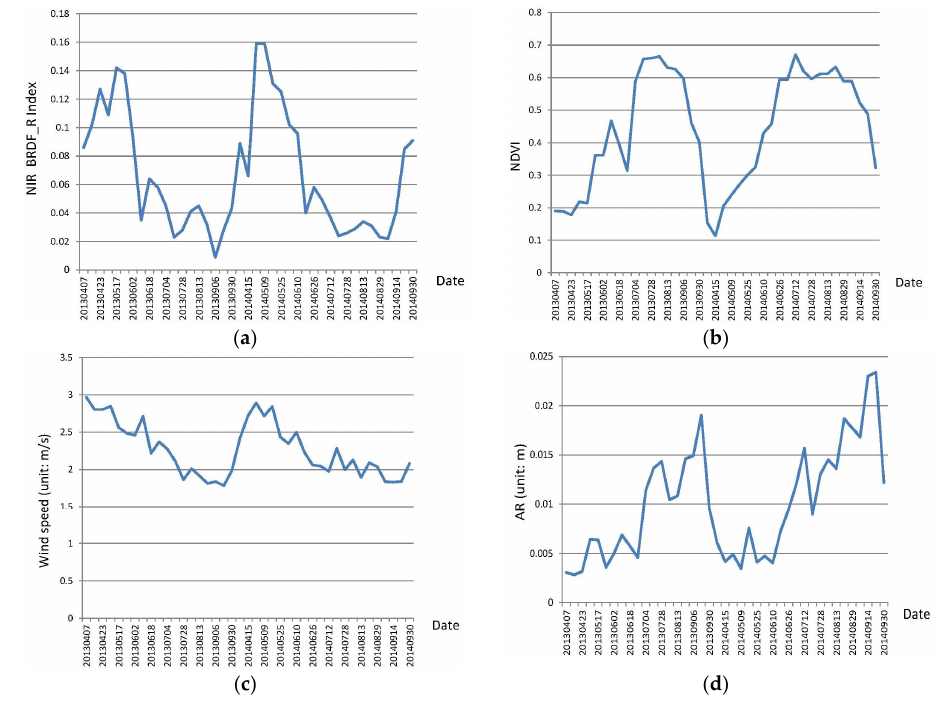
Figure 3. ( a – d ) Change profiles of the Moderate-resolution Imaging Spectroradiometer (MODIS) near-infrared (NIR) bi-directional reflectance distribution function (BRDF)_R index, MODIS normalized difference vegetation index (NDVI), average wind speed, and in-situ aerodynamic roughness (AR) from April to September in 2013–2014.